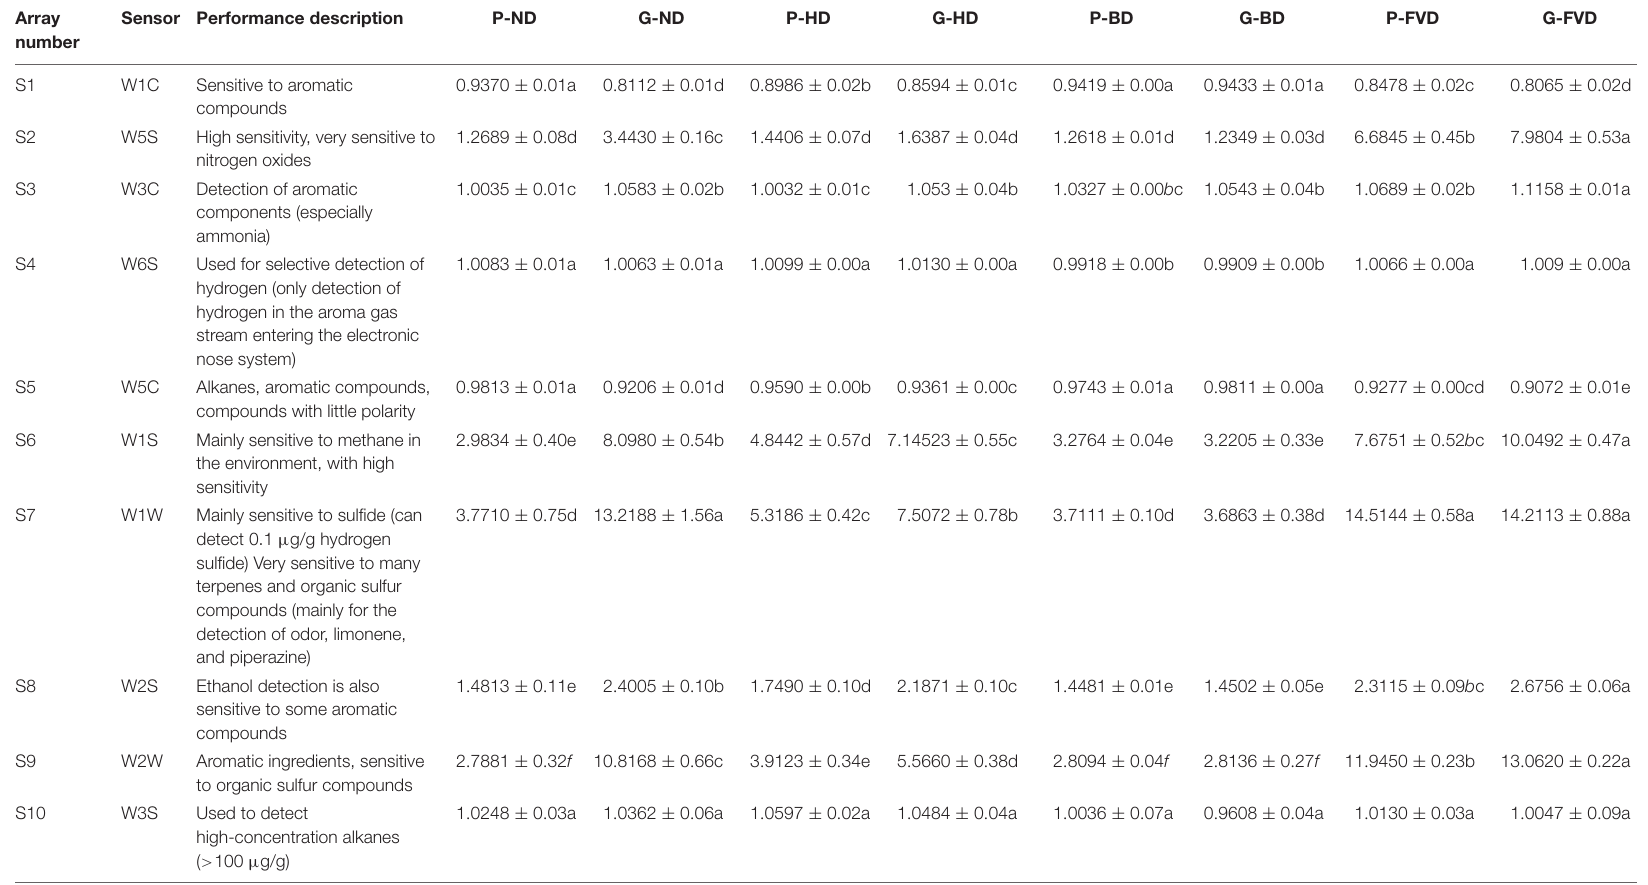
TABLE 2 | The difference analysis of the relative intensity of each odor index of asparagus treated roots with different drying methods. Array